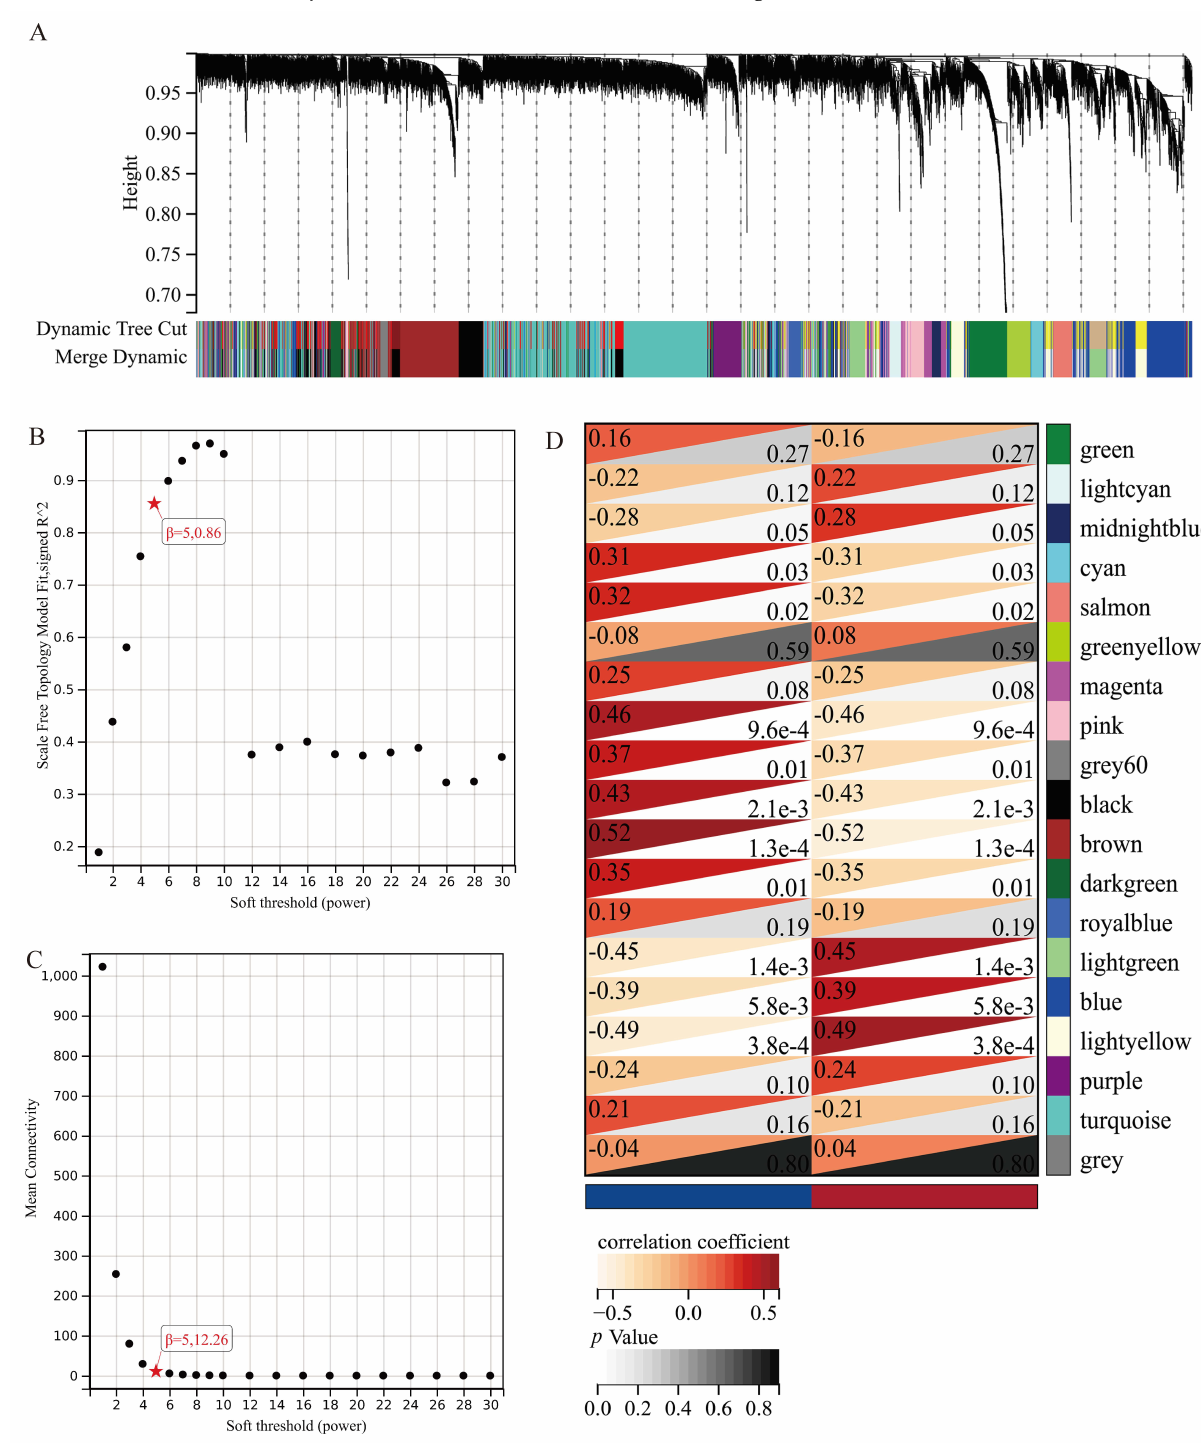
Figure 4. WGCNA cluster detection. Gene cluster ( A ) Independence of scale ( B ) Average connectivity ( C ) Module − phenotype correlation heat map ( D